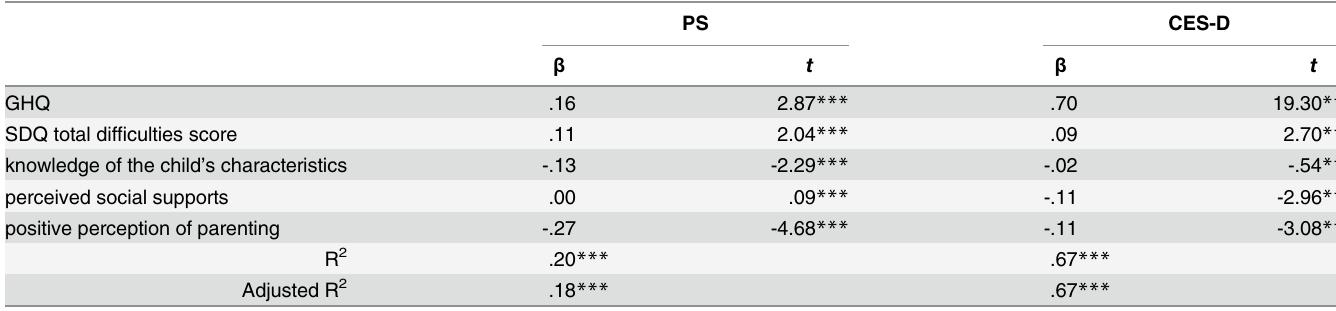
Table 5. Results of multiple regression analysis of PS and CES-D